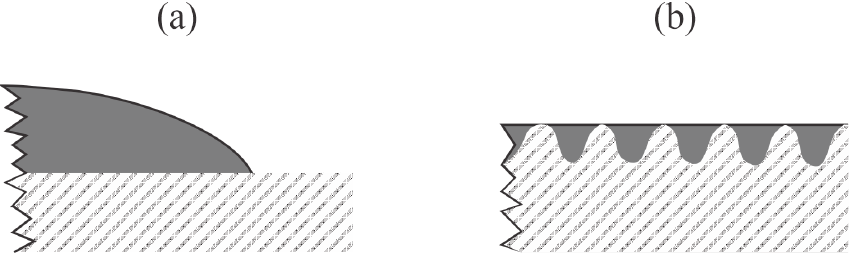
Figure 3. Illustration of the water droplet on a smooth hydrophilic surface ( a ) and superhydrophilic surface of rich morphology on the sub-micrometer scale ( b ).